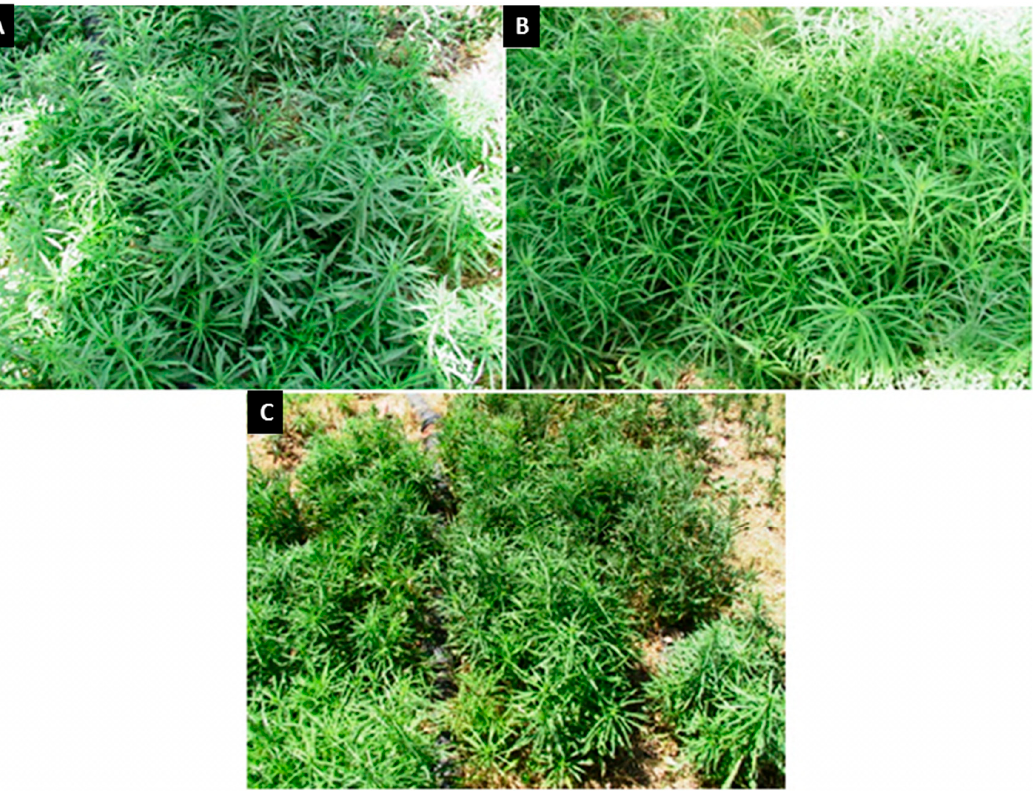
Figure 1. Field demonstration showing; ( A ) C. bonariensis untreated with paraquat, ( B ) treated with paraquat at 2.5 kg ha − 1 , and ( C ) treated with paraquat at 5 kg ha − 1 .